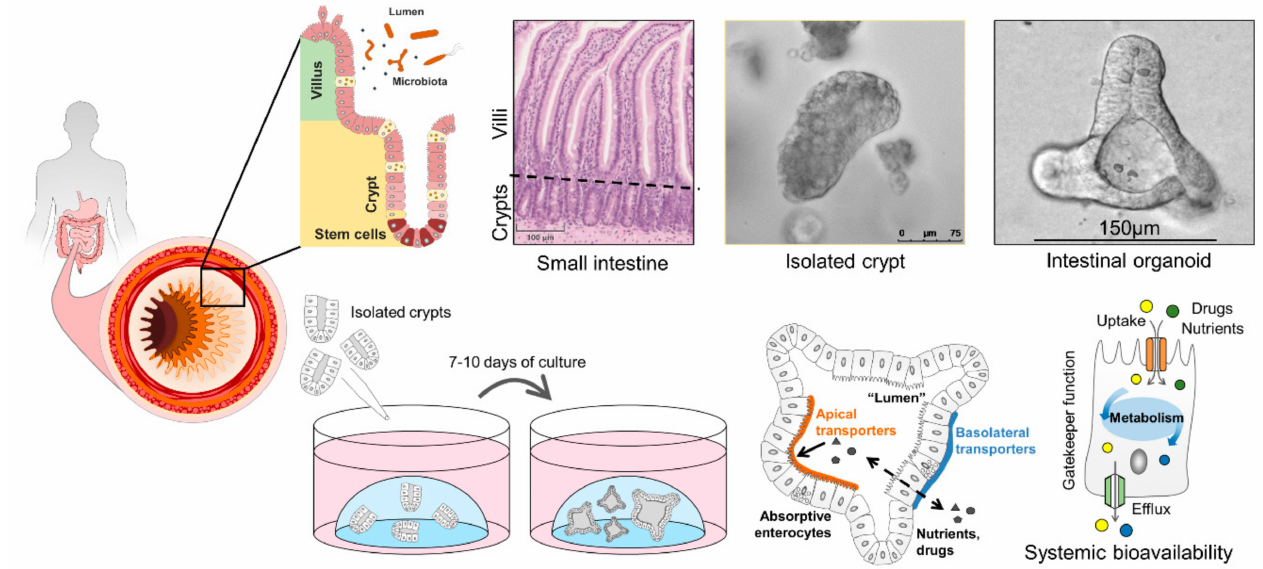
Figure 3. Human intestinal organoids can be generated from isolated primary crypts and constitute a superior model to study intestinal transport processes and intestinal epithelial cell metabolism as gatekeeper for systemic bioavailability of nutrients and